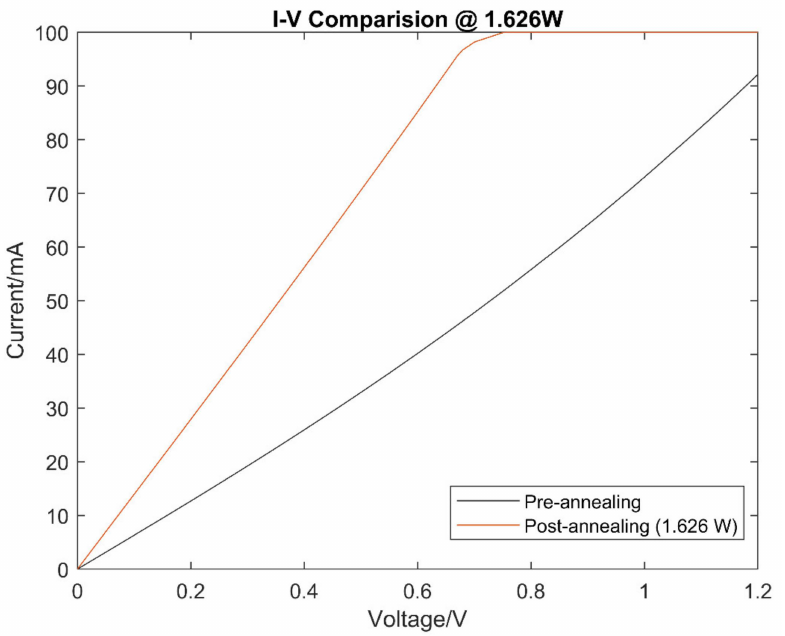
Figure 5. Pre- and post-annealing I-V characteristics of a sample exposed to 1.626 W of average laser power. This suggests that it is possible to produce a more crystalline carbon structure from amorphous carbon through the process of laser annealing. Possible explanations of the results are that laser annealing altered the morphology of the carbon powder at higher laser powers. Graphitisation might have occurred at higher laser power samples,